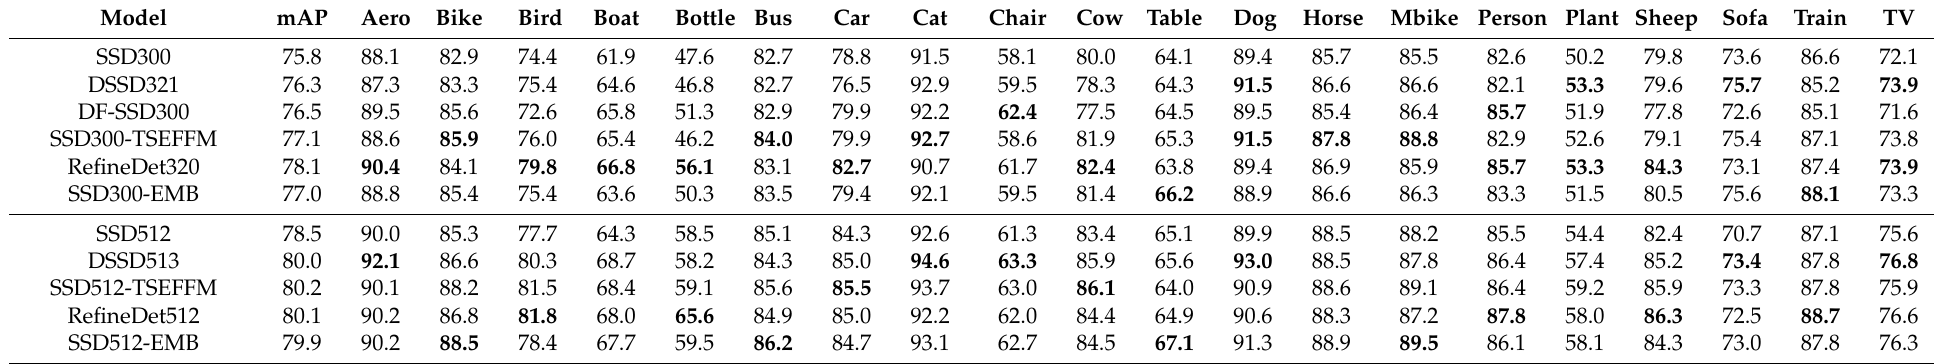
Table 3. Average precision (in %) for our method and others on the PASCAL VOC 2012 test set. Bold indicates the highest average precision for each class. Model